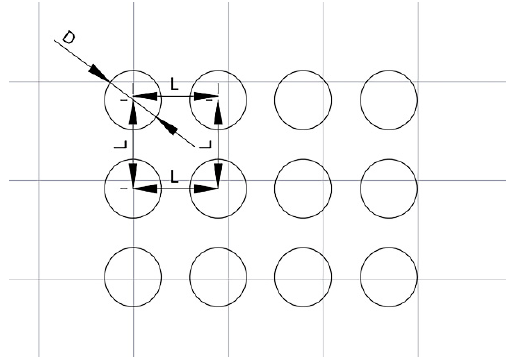
Figure 10. Schematic diagram of pit texture.